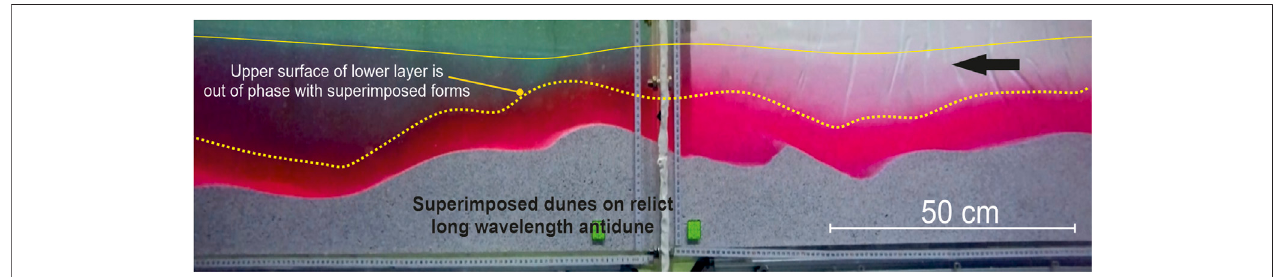
Frontiers in Earth Science |